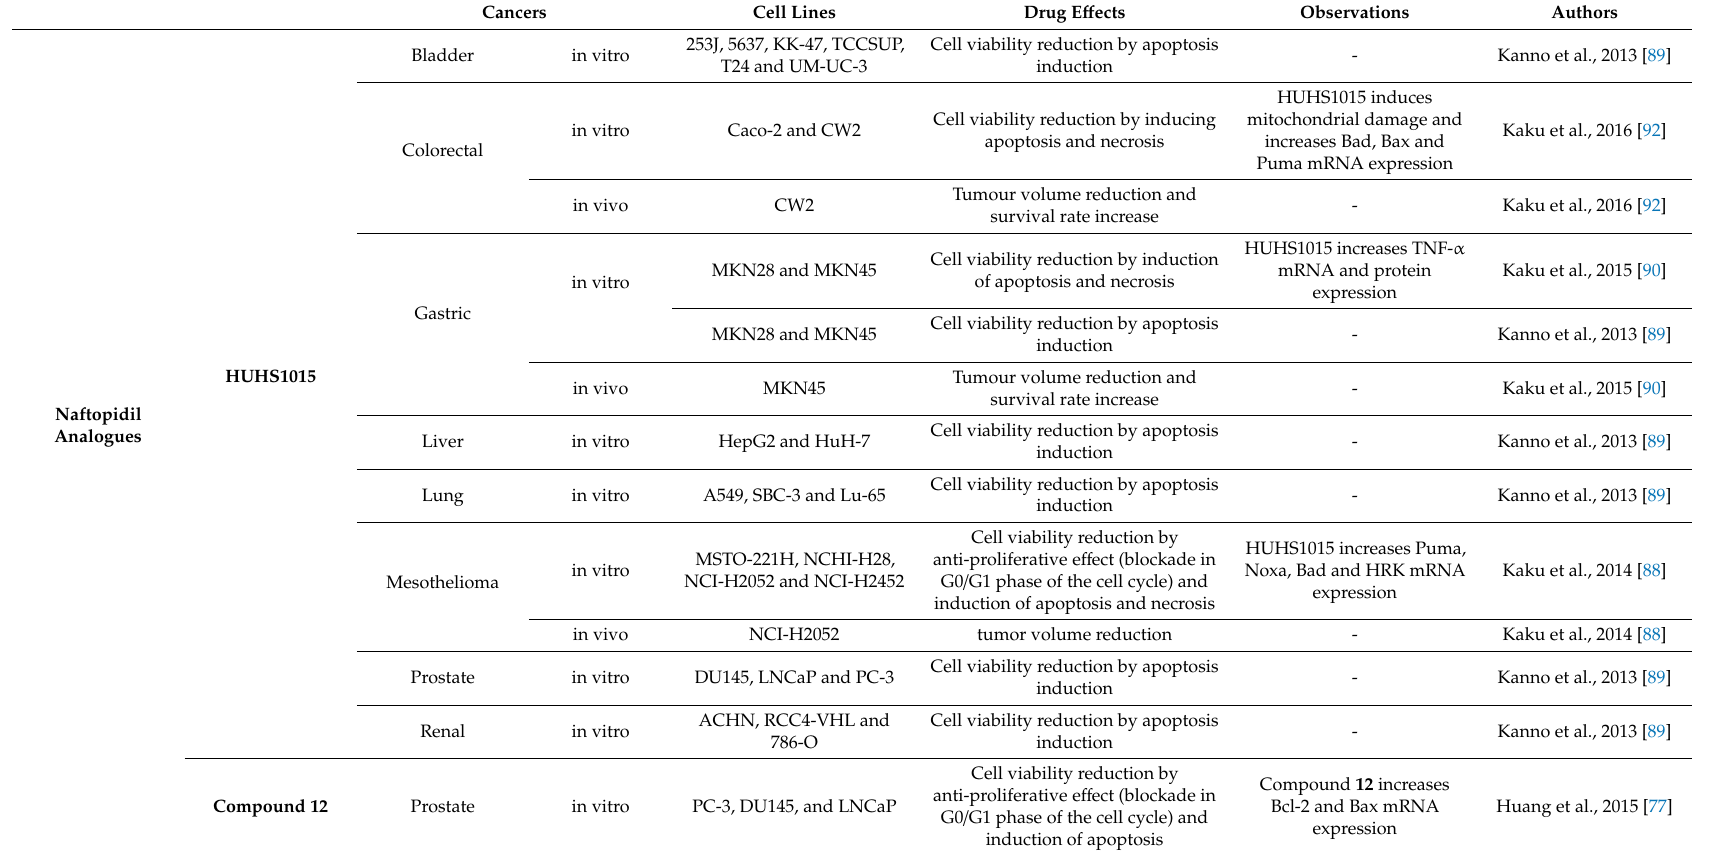
Table 2. Anti-cancerous properties of naftopidil analogues HUHS1015 and compound